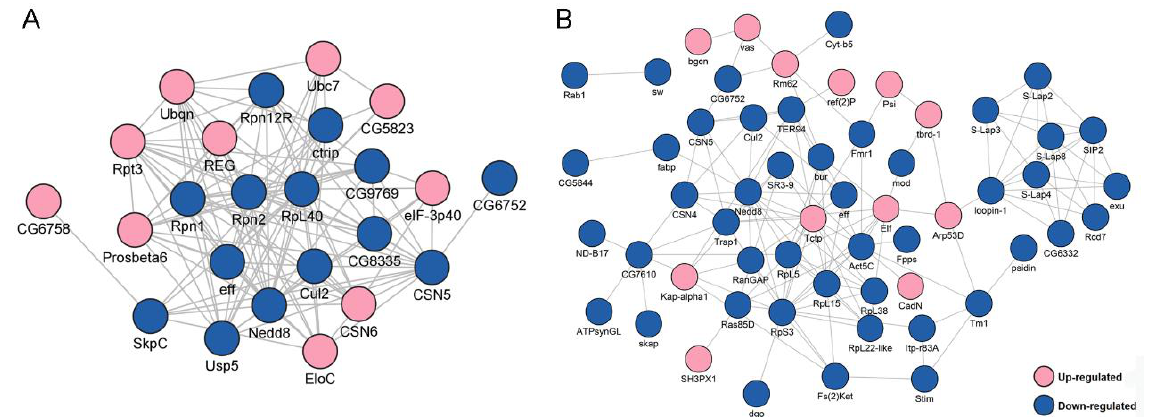
Figure 2. Protein – protein interaction (PPI) analyses of differentially expressed proteins (DEPs) between Wolbachia -infected and uninfected testes of D. melanogaster . ( A ) PPI analyses of DEPs that were involved in the ubiquitin-proteasome pathway. ( B ) PPI analyses of DEPs that were associated with male fertility.